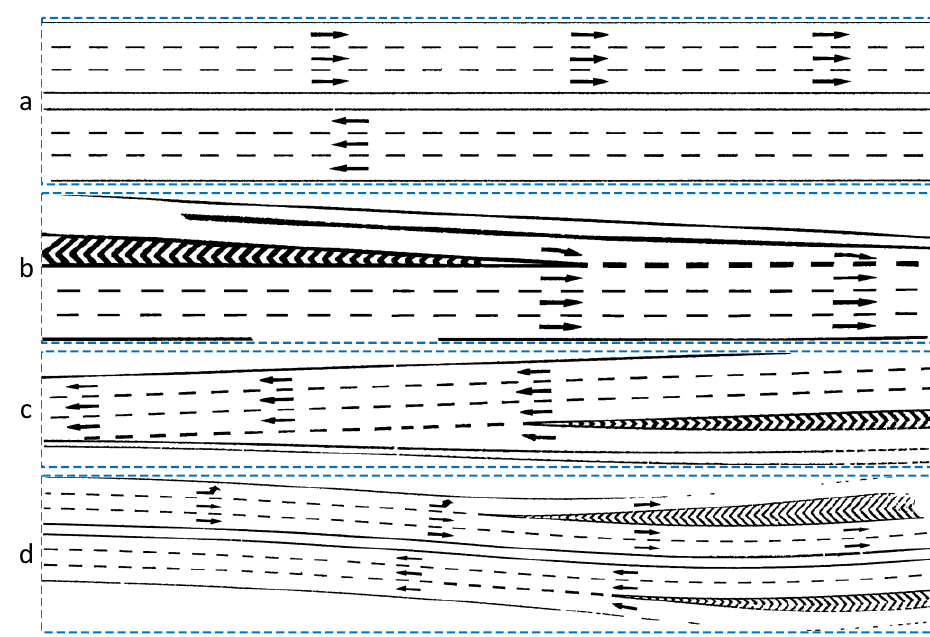
Figure 19. The road marking extracted manually. ( a ) Road marking extracted from Figure 14a; ( b ) Road marking extracted from Figure 14b; ( c ) Road marking extracted from Figure 14c; ( d ) Road marking extracted from Figure